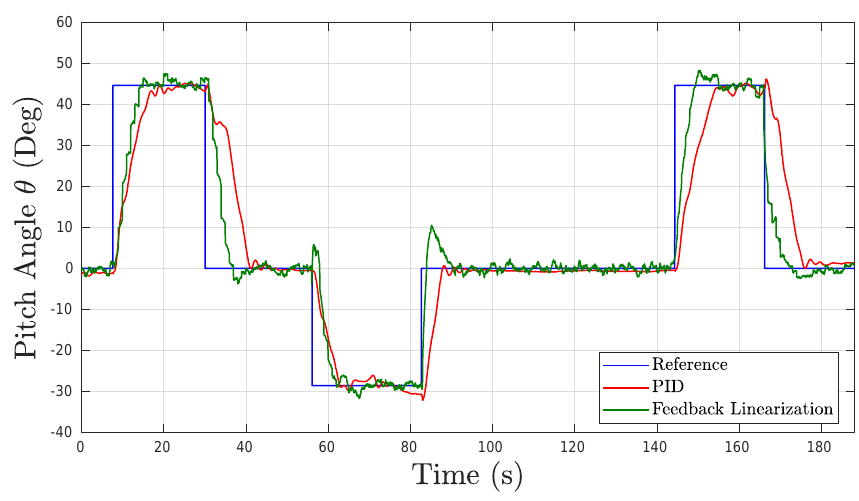
Figure 12. Experimental results obtained in underwater tests in Pitch.